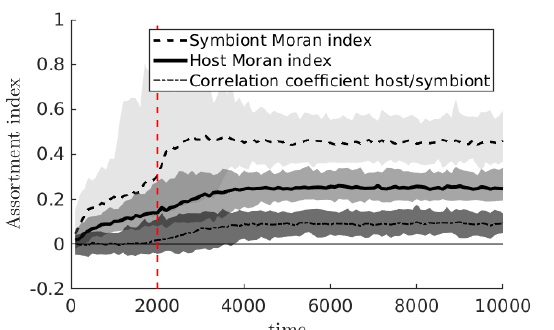
Figure SI.6. Spatial autocorrelation among hosts (plain curve) and symbionts (dashed curve) are described by the Moran index. The spatial correlation between the host and symbionts are described by the correlation coefficient (dash-dotted curve). The shadow regions corresponds to the 95% confidence interval and curves corresponds to the median over 100 replicates. The parameters are similar as Figure